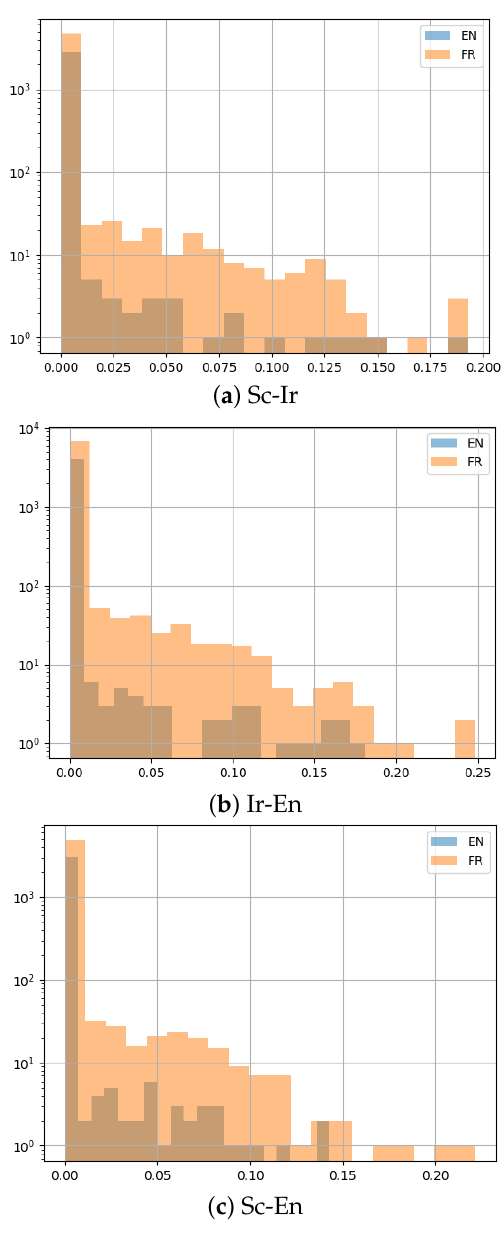
Figure 2. Distribution of misalignment scores across dialect pairs for English and French data